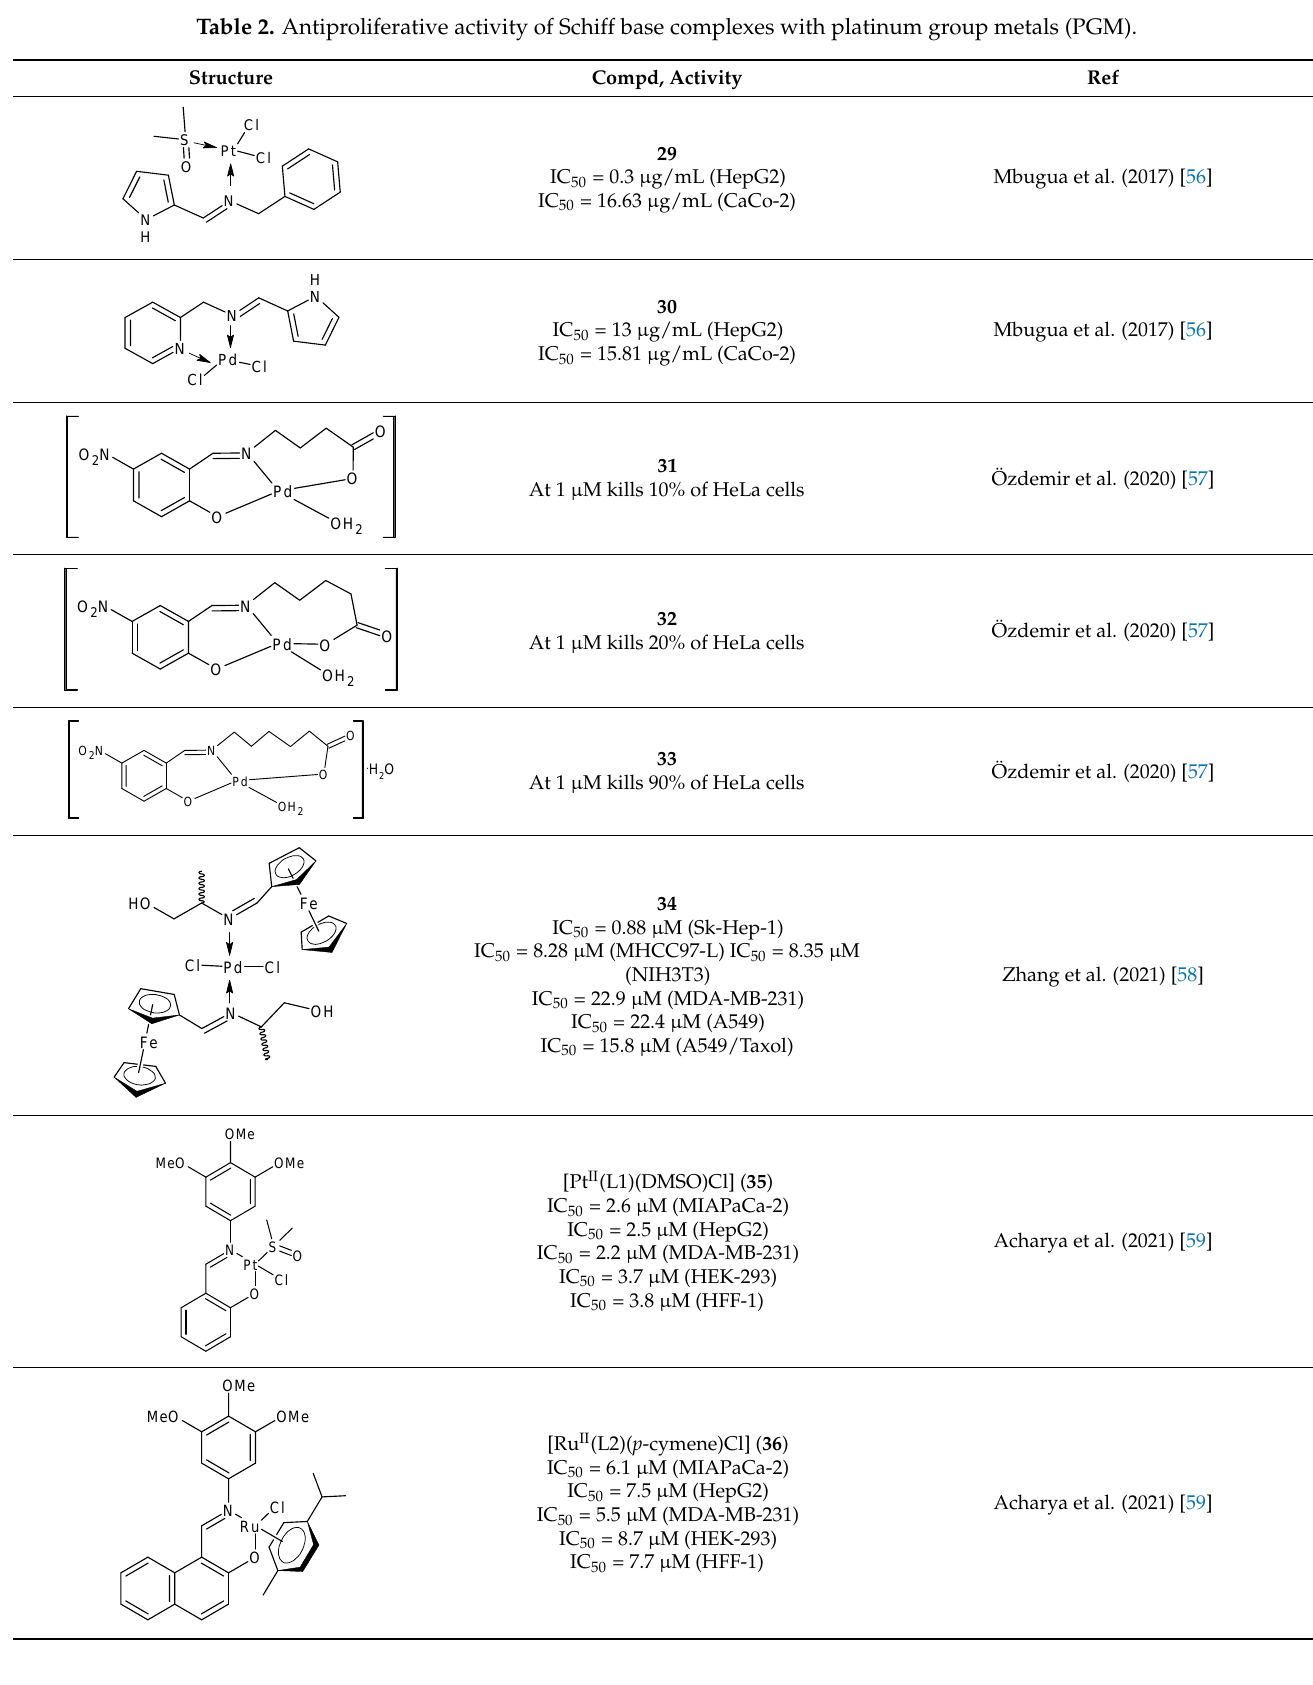
Table 2. Antiproliferative activity of Schiff base complexes with platinum group metals (PGM). Structure